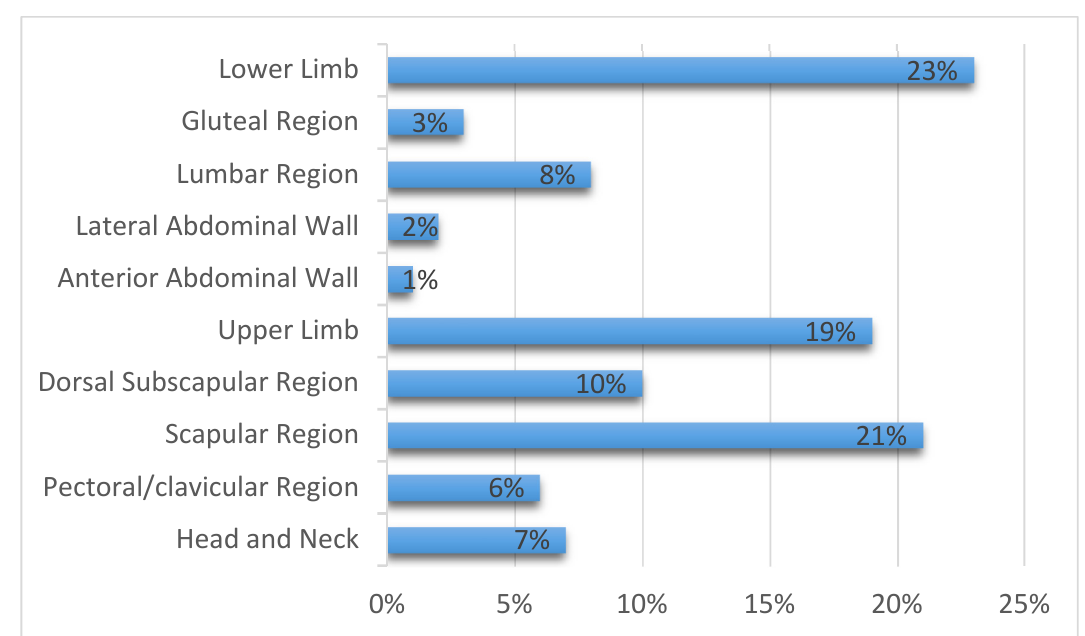
Figure 1. Localization of primary melanoma included in this study and their frequency. All patients included in this study, underwent SLNB for cutaneous melanoma with a stage equal or greater than pT1b according to AJCC 8th (melanoma with a thickness between 0.8 mm to 2 mm without ulceration or melanoma with a thickness less than 0.8 mm with ulceration); cases previously performed with the last AJCC 7th update were re-staged with the new classification.